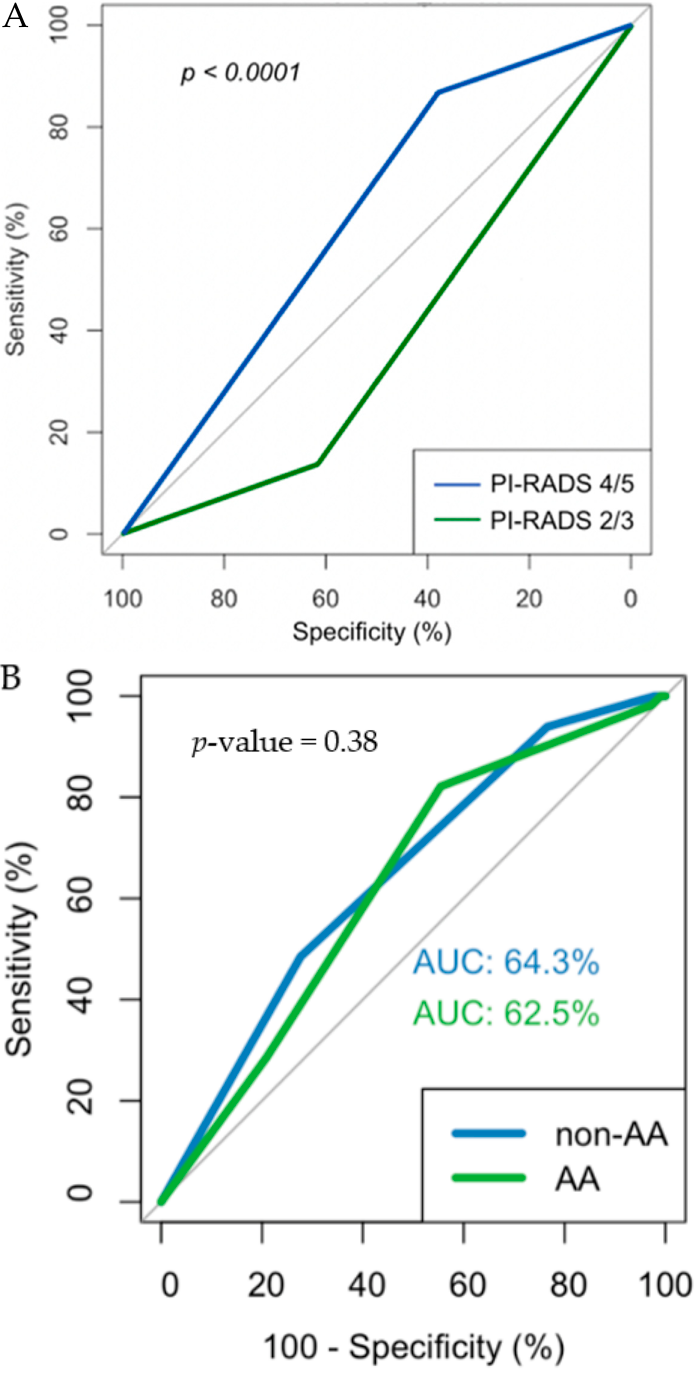
Figure 2. ROC regarding likelihood of clinically significant prostate cancer detection. ( A ) PI ‐ RADS 4/5 were found to have statistically higher AUC. ( B ) When comparing racial groups, we found no statistical